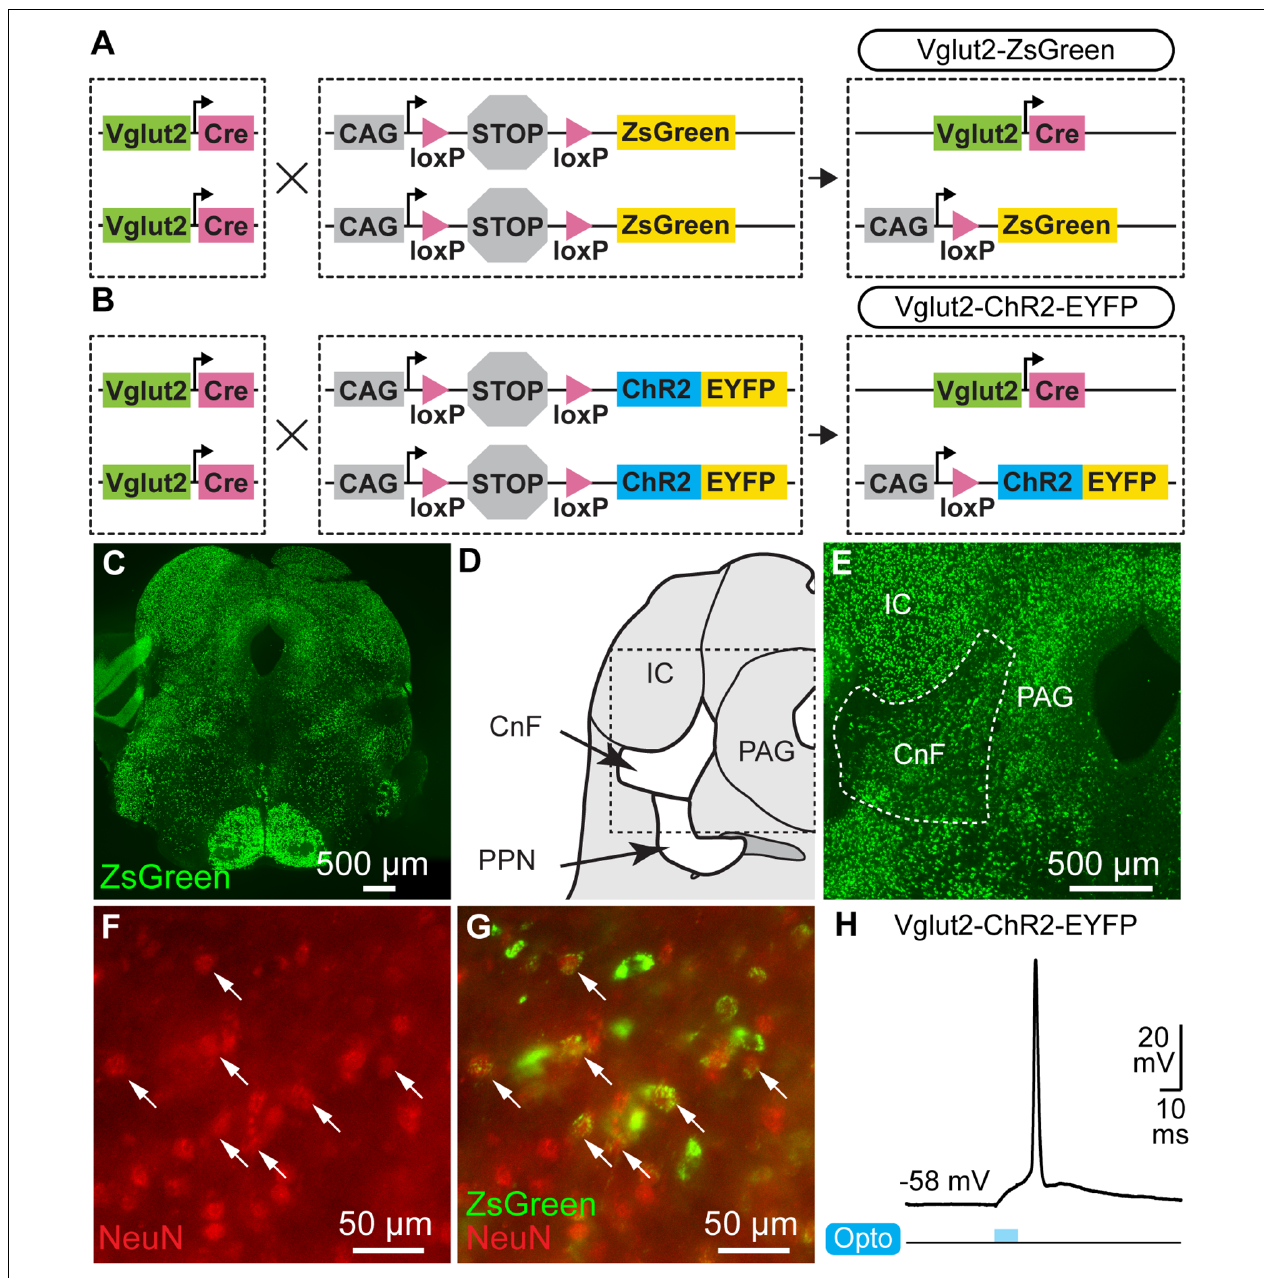
FIGURE 1 | Cre-dependent expression of channelrhodopsin or ZsGreen in neurons of the Mesencephalic Locomotor Region (MLR) expressing the vesicular glutamate transporter 2 (Vglut2). (A) For anatomical experiments, homozygous mice expressing Cre-recombinase under the control of the Vglut2 promoter (Vglut2-Cre, see “Materials and Methods” section) were crossed with homozygous mice with ZsGreen preceded by a STOP cassette flanked by loxP sites preventing ZsGreen expression. In the resulting heterozygous mice (Vglut2-ZsGreen), if Vglut2 is expressed during cell lifetime, Cre-dependent recombination removes the STOP cassette, allowing permanent expression of ZsGreen under control of the CAG promoter. (B) For optogenetic experiments, mice homozygous for Vglut2-Cre were crossed with mice homozygous for channelrhodopsin (ChR2) and enhanced yellow fluorescent protein (EYFP) preceded by a STOP cassette flanked by loxP sites preventing their expression. In the resulting heterozygous mice (Vglut2-ChR2-EYFP), if Vglut2 is expressed during cell lifetime, Cre-dependent recombination removes the STOP cassette, allowing permanent expression of ChR2-EYFP under control of the CAG promoter. (C) Photomicrographs of transversal brain slices from Vglut2-ZsGreen mice at the MLR level. (D) Schematic representation of a brain slice at the MLR level. (E) Higher magnification of the brain slice in (C) at the level of the CnF. (F,G) Epifluorescent images taken in the CnF, showing that cells expressing ZsGreen (green) are immunopositive for the neuronal marker NeuN (red). (H) Whole-cell patch-clamp recording of a neuron recorded in a brainstem slice of a Vglut2-ChR2-EYFP mouse at the level of the MLR. The neuron spikes an action potential at short latency in response to a 10 ms blue light pulse. CnF, cuneiform nucleus; IC, inferior colliculus; PAG, periaqueductal gray; PPN, pedunculopontine